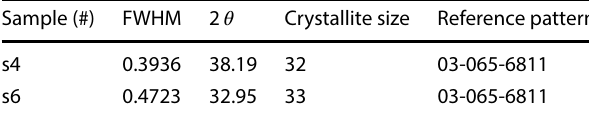
O in s4 and s6 2